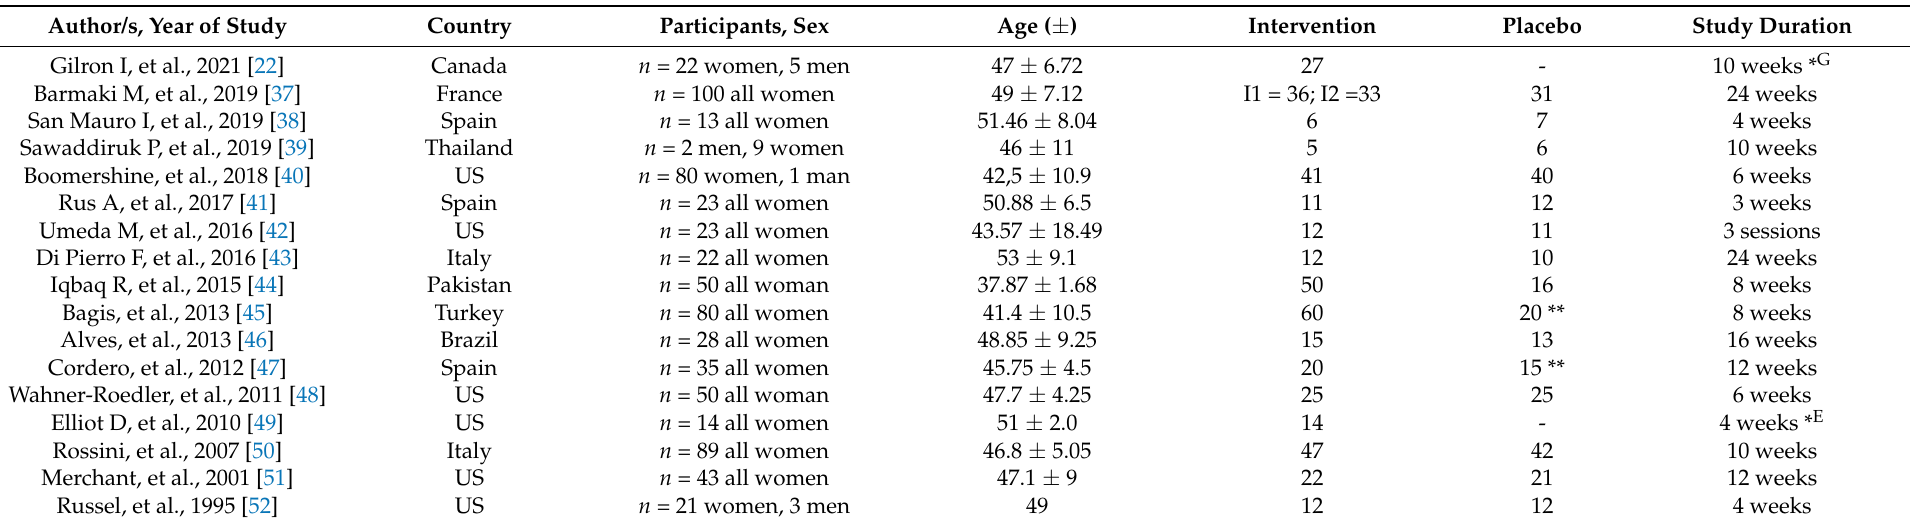
Table 2. Synthesis of the studies included in the systematic review with type of study, participants, and